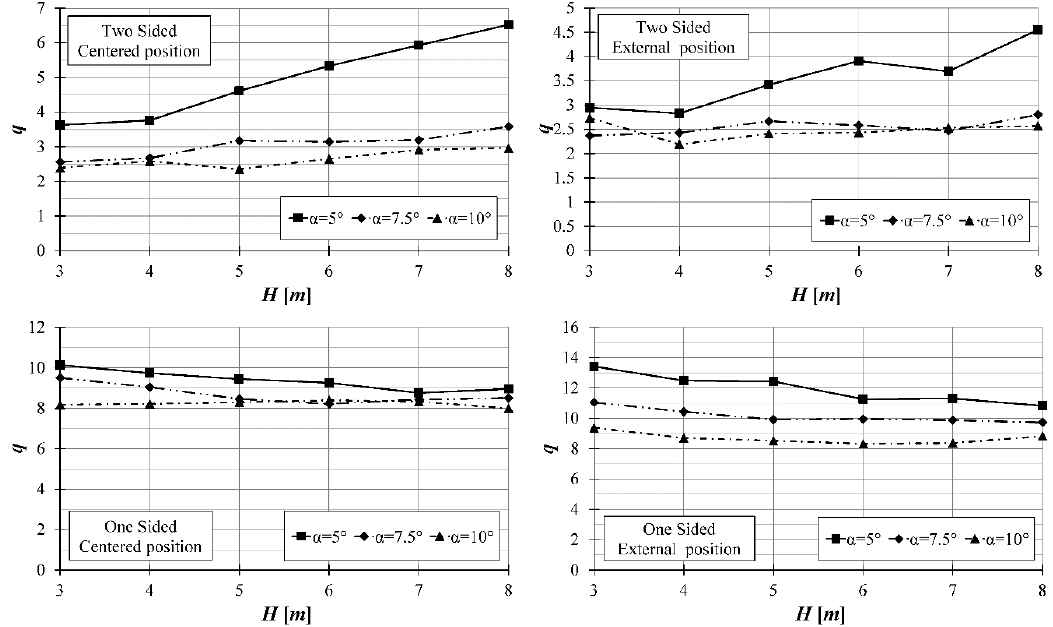
Figure 11. Force reduction factor versus height H — ρ =1‰, Spectrum A2 , GFRP material.